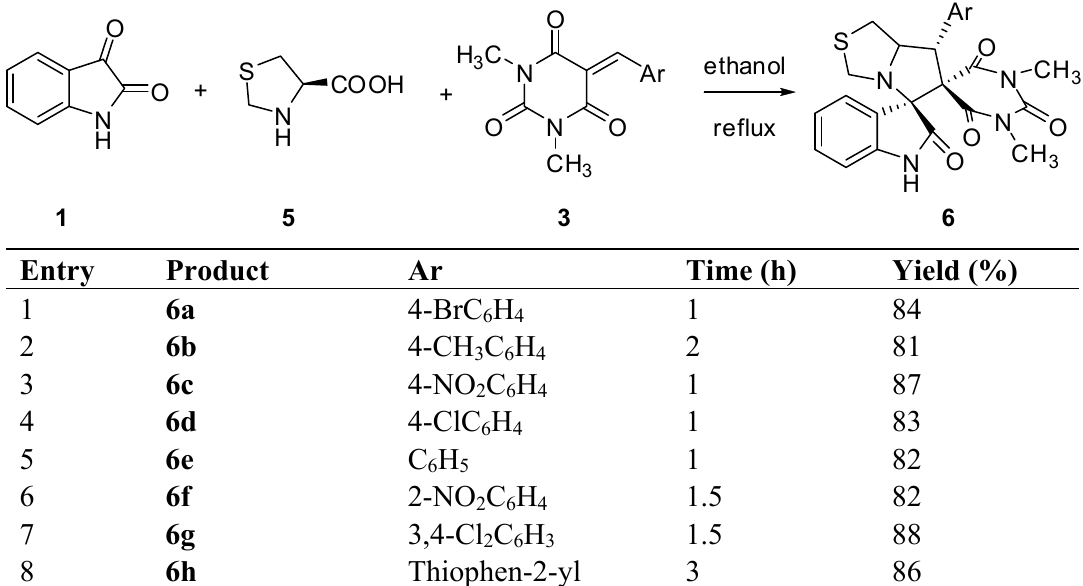
Table 3. Synthesis of dispirooxindole derivatives 6 via three-component reactions.